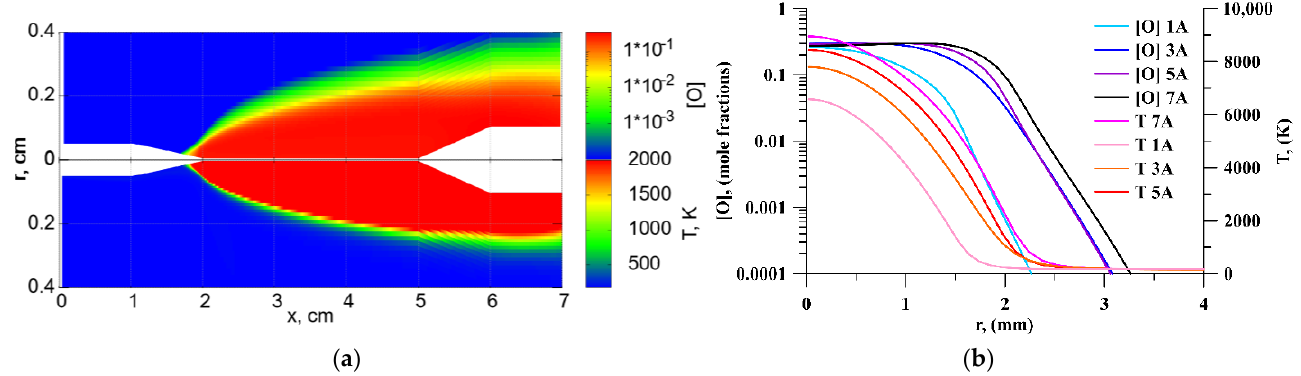
Figure 13. The 2D distribution of atomic oxygen (top) and temperature (bottom) ( a ); radial distribu- tions for the 44 mm section ( b ) for current 5 A.